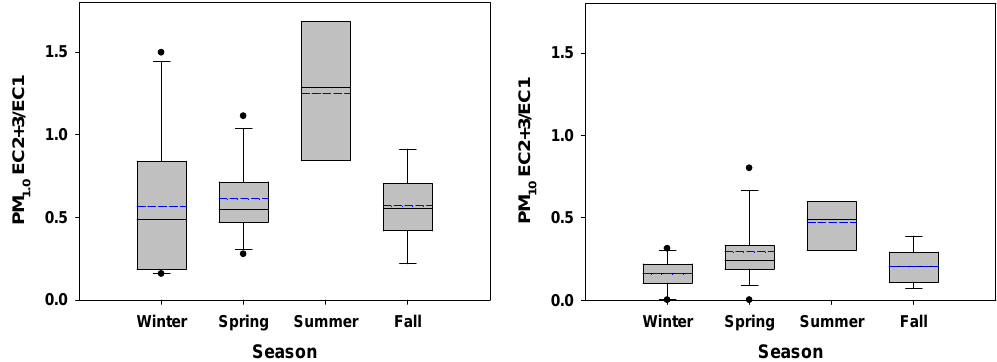
Fig. 7. Seasonal variations of soot-EC to char-EC in PM 1 . 0 and PM 10 . See Fig. 3 for the detailed explanation of box and whisker plot.